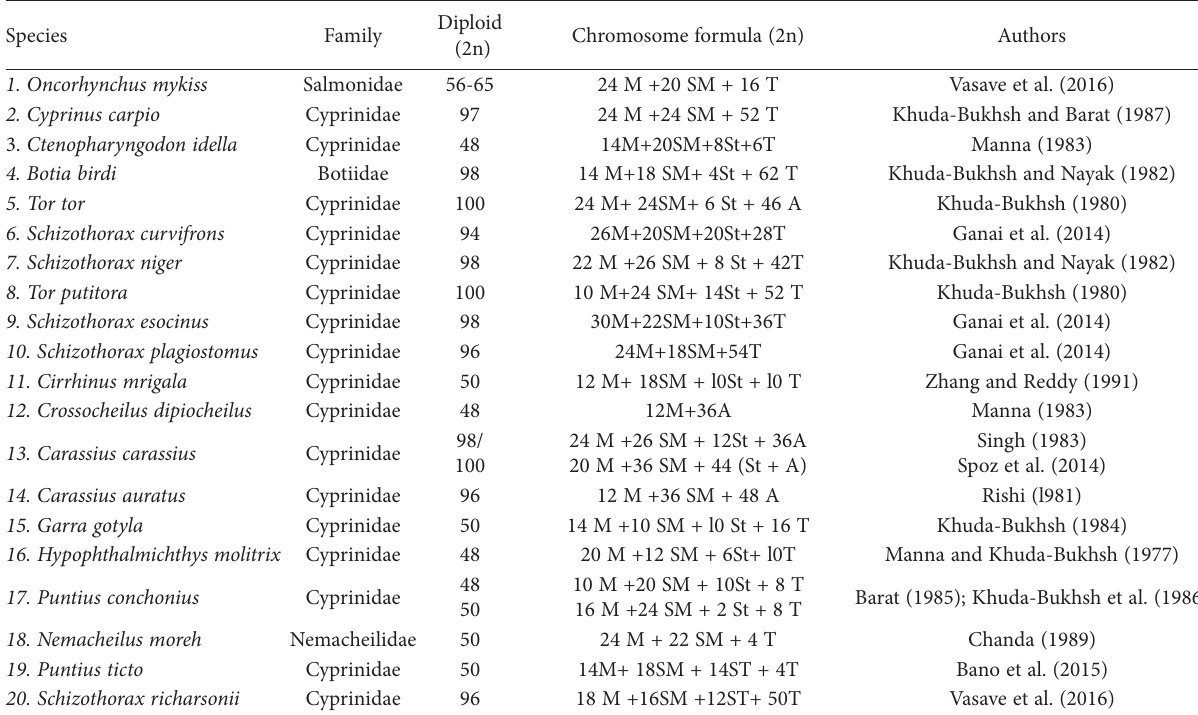
Table 3. Karyotypic analysis of various fresh water fish species.